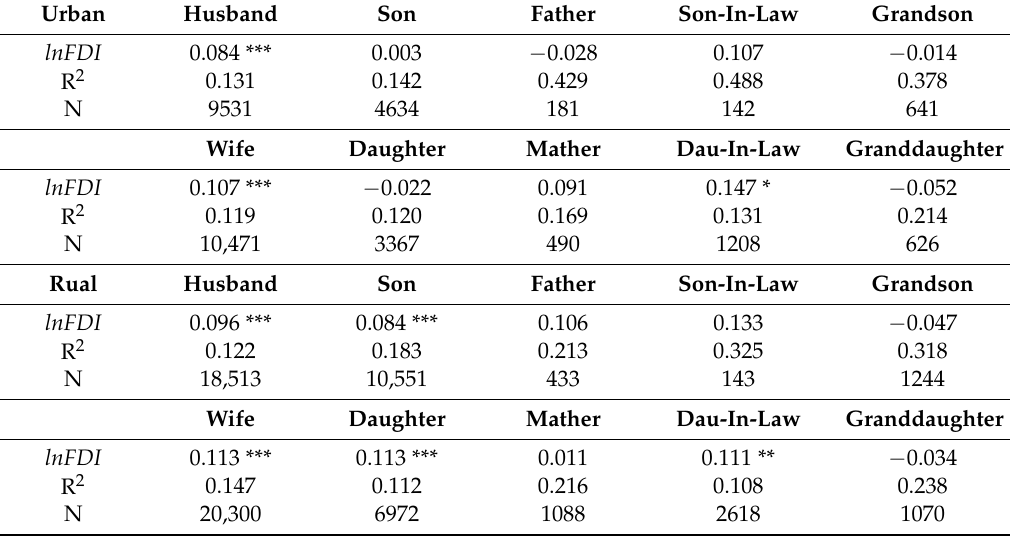
Table 3. Family role regressions results (dependent variable: ln individual